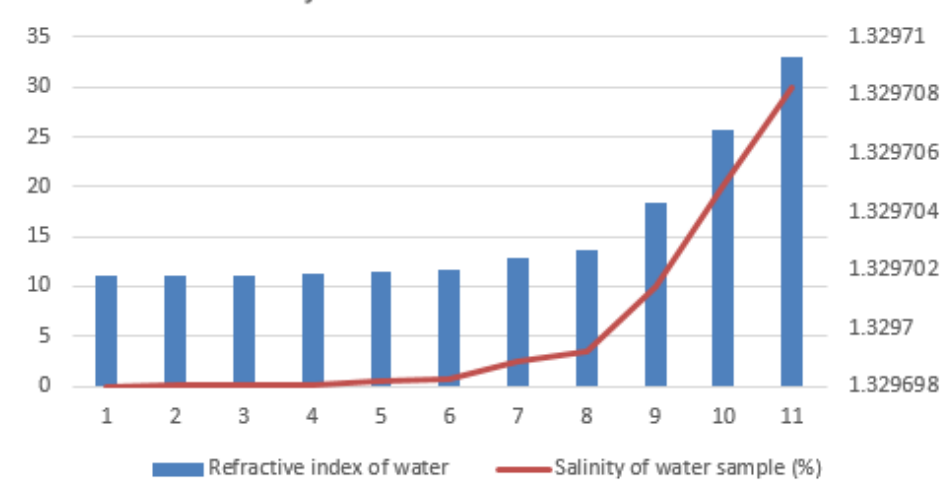
Figure 4. Salinity vs. RI of water. The figure shows variation of the RI with a change in the salinity of water.